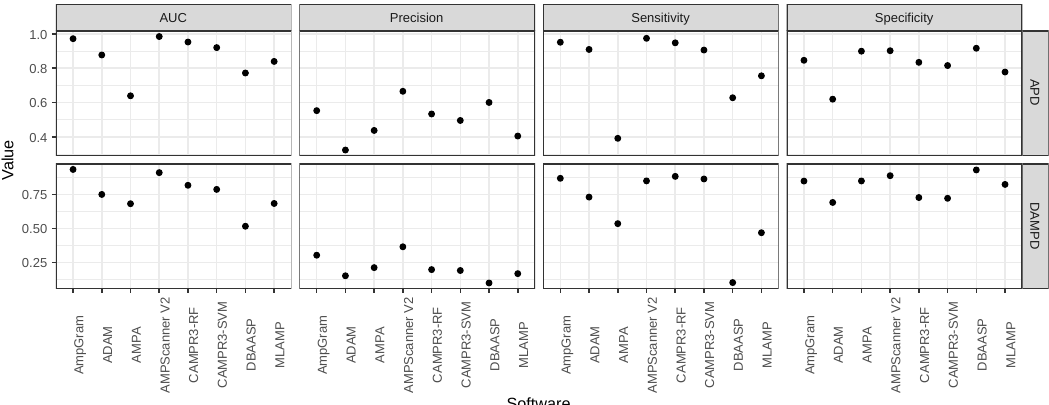
Figure 2. Comparison of AmpGram and AMPscanner [24] performance on the APD and DAMPD dataset with other predictors from Gabere and Noble’s benchmark and according to their methodology [29]. Sequences used to train either AmpGram or AMPScanner were removed from the DAMPD dataset. The benchmark without their removal is presented in Figure S3 in the Supplementary Materials. The very low values of precision are due to the very large negative dataset used (for details, see Section